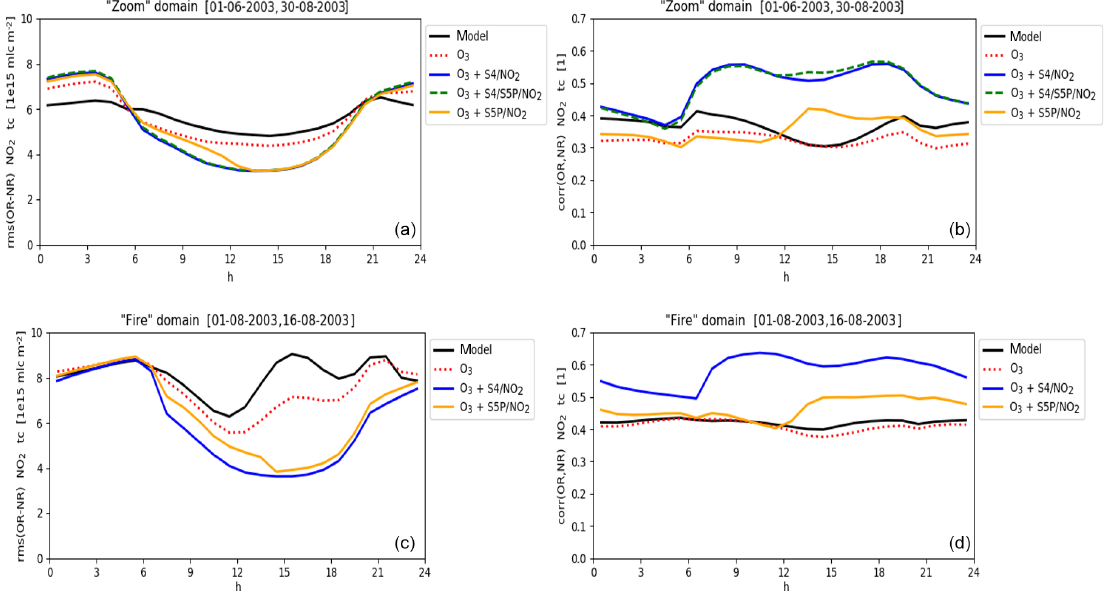
Figure 12. RMSE (a, c) and correlation (b, d) with NR tropospheric NO 2 column for the summer period and zoom domain (a, b) and the fire episode (1–16 August 2013) and domain (c, d) . Prior to (black line) and after assimilation of observations (coloured lines – ground-based O 3 only: dotted red; ground-based O 3 + S4 NO 2 : blue; ground-based O 3 + S5P NO 2 : yellow; and ground-based O 3 + S4 and S5P NO 2 : dashed green).